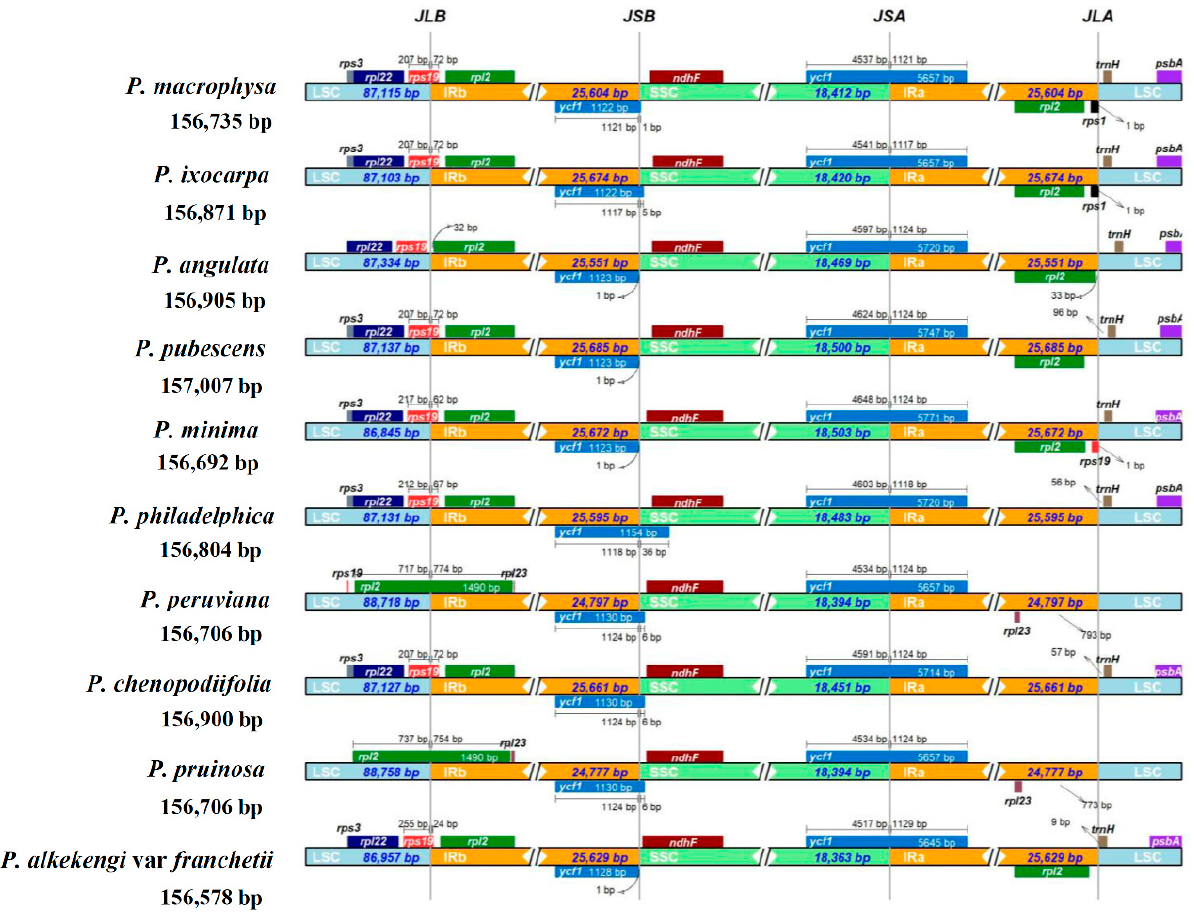
Figure 5. Comparison of the borders of the IR, SSC and LSC regions among the 10 Physalis cp genomes.